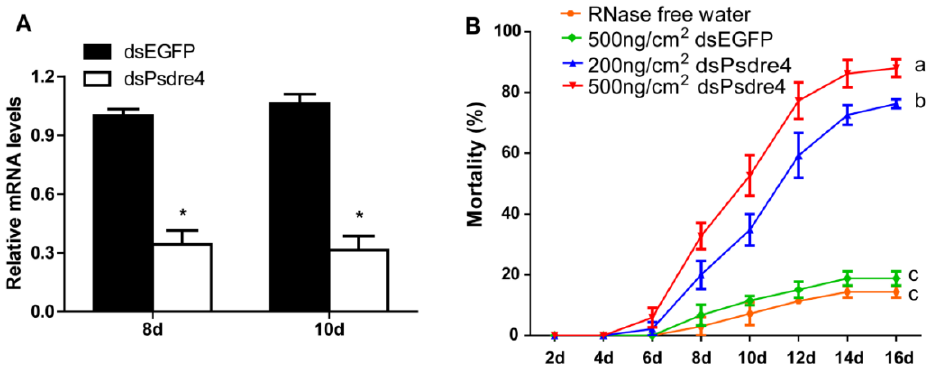
Figure 4. Effects of silencing Psdre4 on P. striolata adults by dsRNA oral delivery. ( A ). Relative expression levels of Psdre4 in 2-day beetles after treatment with 500 ng/cm 2 dsEGFP or dsPsdre4. Data are plotted as mean ± SEM. Statistical analysis was evaluated using Student’s t -test (* p < 0.05). ( B ). The percentage mortality of beetles after dsPsdre4 feeding. Data are plotted as mean ± SEM. Statistical significance between samples on the 16th day was evaluated using one-way ANOVA followed by Duncan’s multiple-range test. Different letters above each bar indicate that the values differed significantly at p <